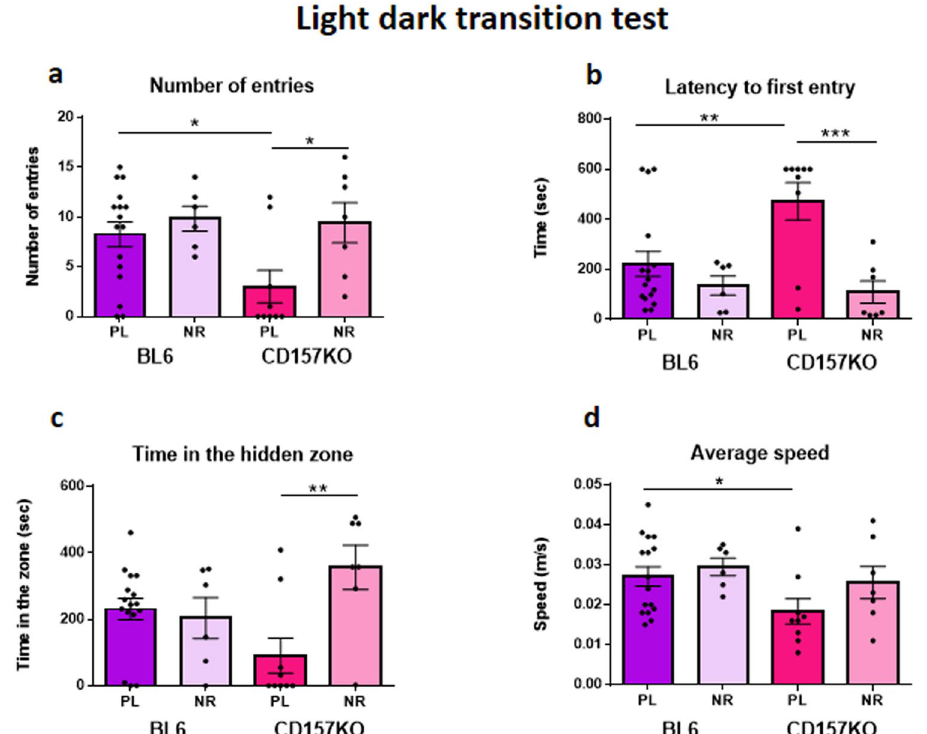
Figure 3. Effects of gavage supplementation of nicotinamide riboside (NR) for 12 days on anxiety-like behaviour in the light-dark transition test in wild-type (BL6) and CD157KO male mice, compared with that with saline treatment (PL). (a) Transition numbers between the two compartments. Two-way ANOVA; F 1,34 = 5.766, P = 0.022; Bonferroni’s post hoc analysis revealed a significance between placebo and NR in CD157KO mice, P < 0.05. (b) Latency of the first entry into the dark zone. Two-way ANOVA; effect of treatment, F 1,34 = 12.62, P = 0.0011; genotype and treatment interaction, F 1,34 = 4.695, P = 0.0374. Bonferroni’s post hoc tests showed significance between placebo and nicotinamide riboside in CD157KO mice, P < 0.001. (c) Time spent in the dark zone. Two-way ANOVA; treatment, F 1,34 = 5.363 P = 0.0267; interaction between genotype and treatment, F 1,34 = 8.005, P = 0.0078). Bonferroni’s post hoc tests revealed significance between placebo and nicotinamide riboside in CD157KO mice, P < 0.01 ( d ) The average speed in the light compartment. Two-way ANOVA; for genotype ( F 1,34 = 4.593, P = 0.0393). * P < 0.05, ** P < 0.01, and, *** P < 0.001,